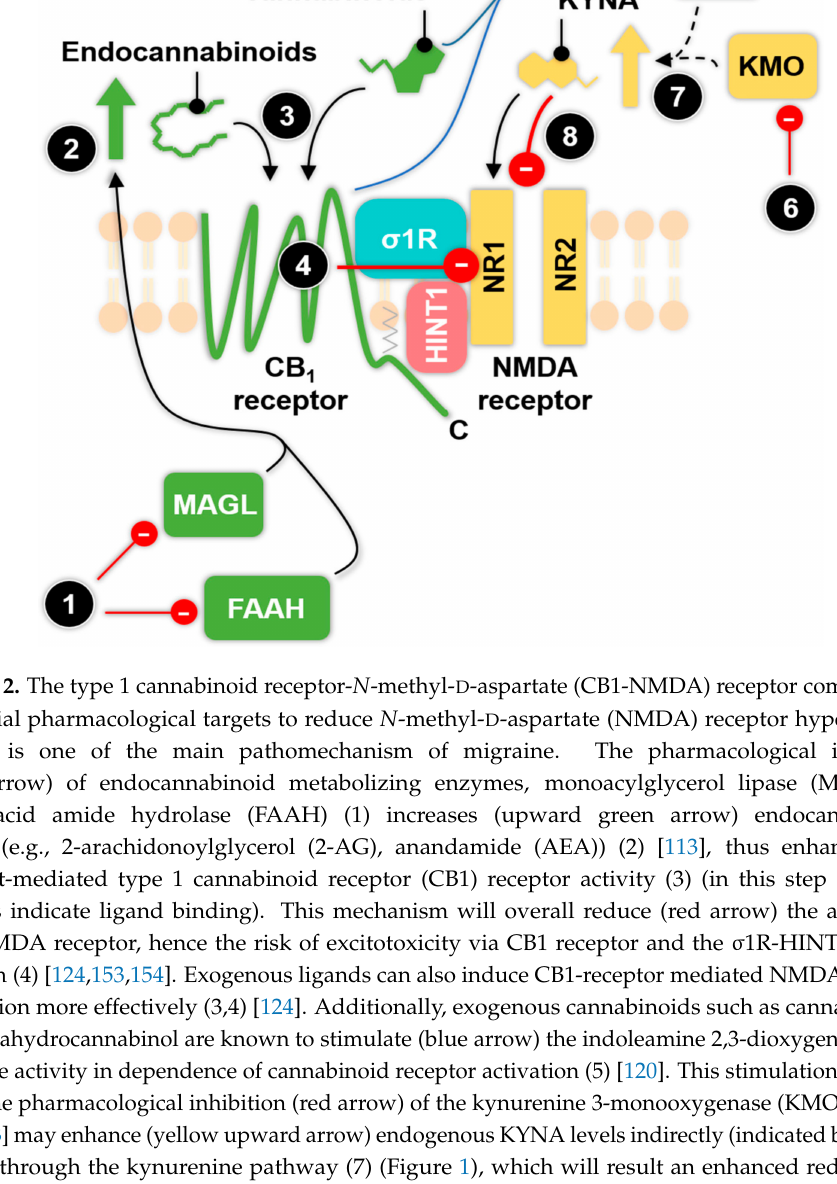
the sigma 1 receptors- histidine triad nucleotide-binding protein 1 ( σ 1R-HINT1) protein tandem, which associates the two receptors and it is based on Rodriguez-Munoz and co-worker’s review [124]. NR1 and NR2 indicate the two types of subunit of the NMDA receptor and the C terminus of the CB1 receptor is also highlighted. The green color indicates endocannabinoid, while the yellow color indicates kynurenine system related ligands, receptors, enzymes or mechanisms. The shapes of the indicated ligands, receptors or enzymes are schematic or overly simplified representations of their